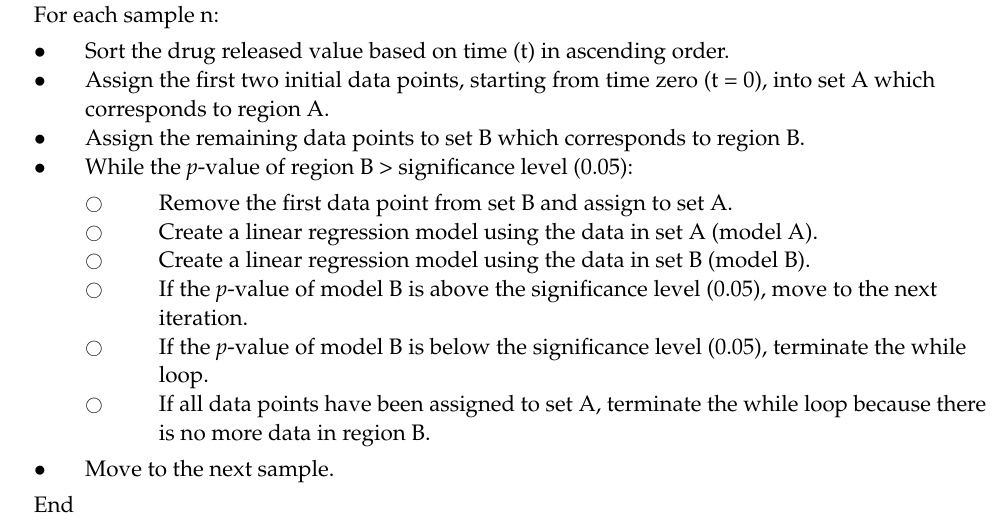
Algorithm 1: Pseudo-code to determine sample’s steady-state